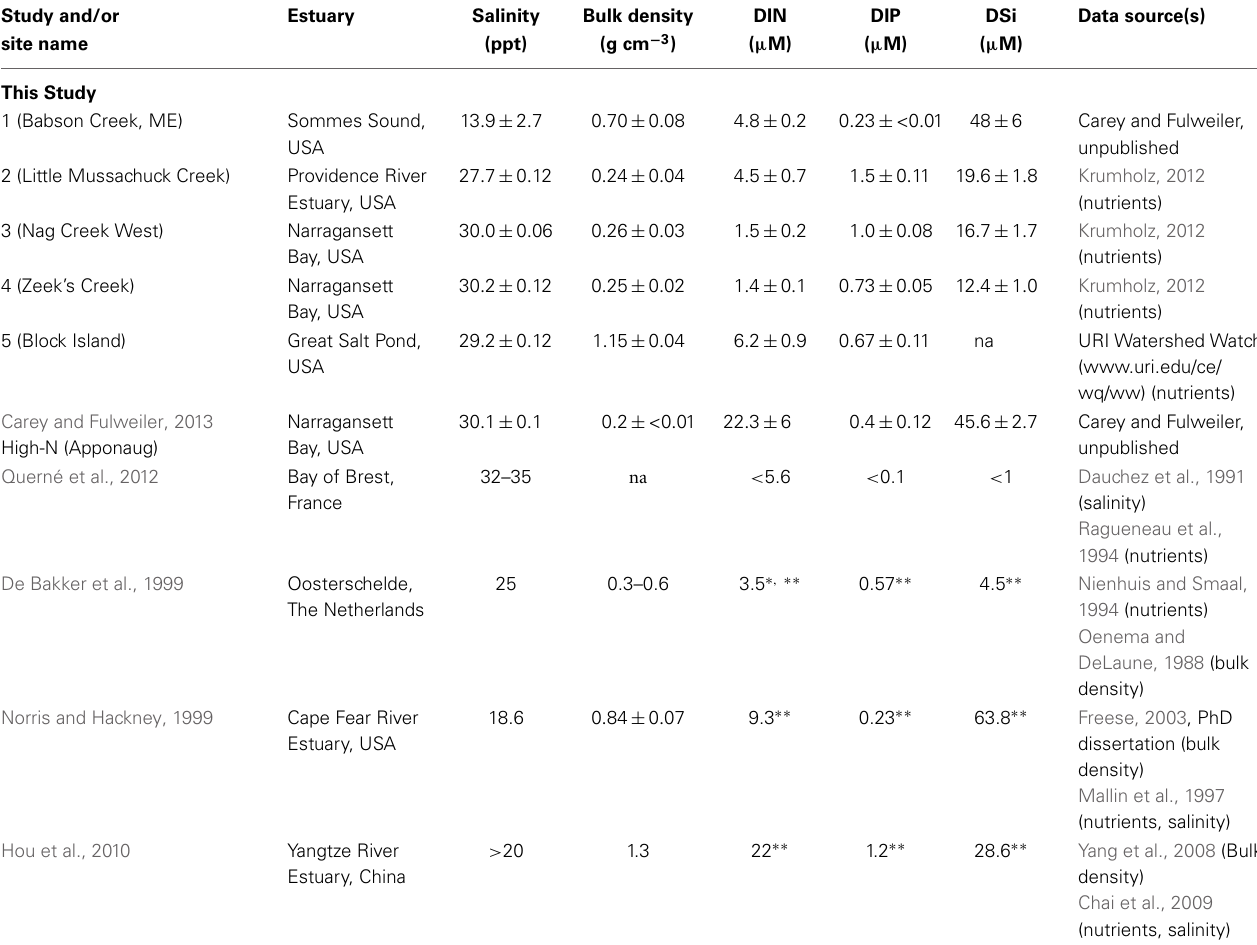
Table 1 | Site characteristics of estuaries adjacent to the salt marshes included in analysis. Study